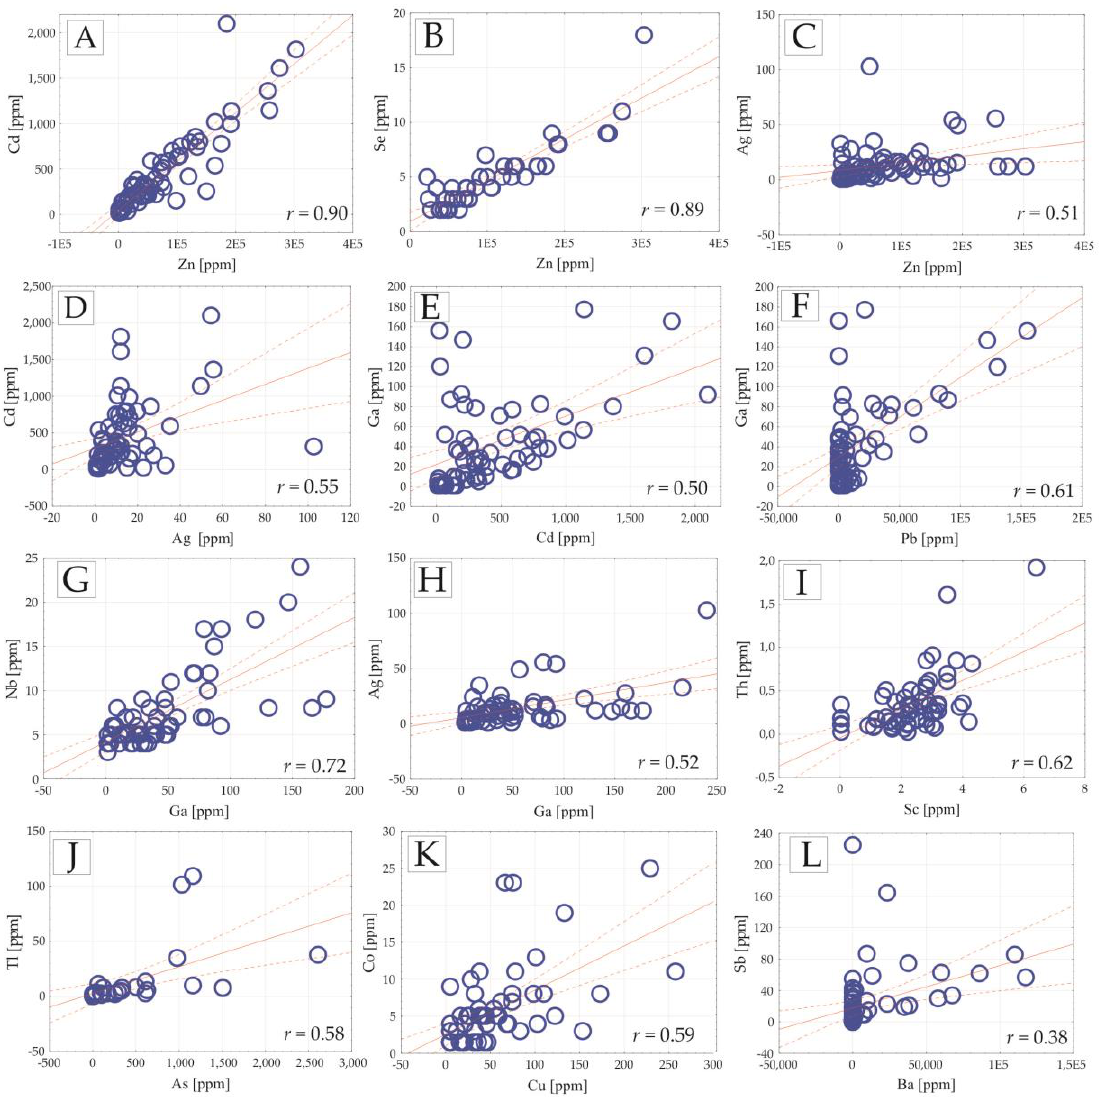
Figure 11. Bivariate plots of trace elements (ppm) in bulk-rock samples of Zn-Pb ores from the MVT deposits in Poland: ( A ) Zn vs. Cd, ( B ) Zn vs. Se, ( C ) Zn vs. Ag, ( D ) Ag vs. Cd, ( E ) Cd vs. Ga, ( F ) Pb vs. Ga, ( G ) Ga vs. Nb, ( H ) Ga vs. Ag, ( I ) Sc vs. Th, ( J ) As vs. Tl, ( K ) Cu vs. Co, and ( L ) Ba vs. Sb. Note: 95% confidence intervals are shown as the red dotted lines, while the line of best fit is shown as the red line.